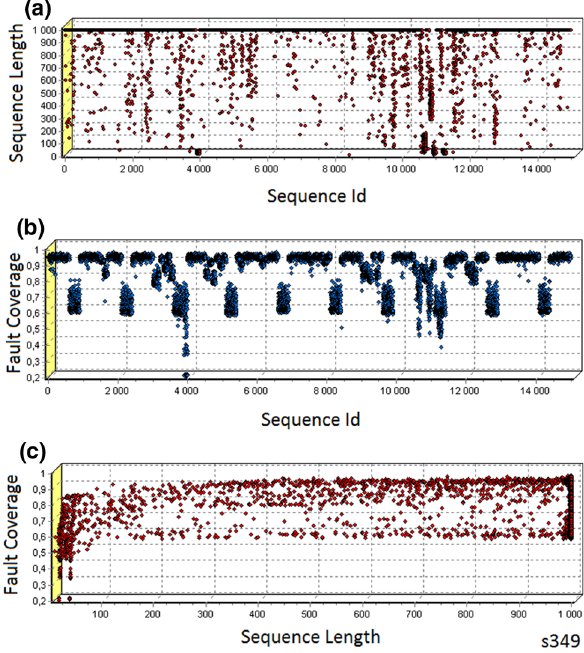
Fig. 11 Simulation graph for s349 a sequence length vs. sequence id, b FC vs. sequence id and c FC vs. sequence length. STP (Id 1–7500), CSTP (Id